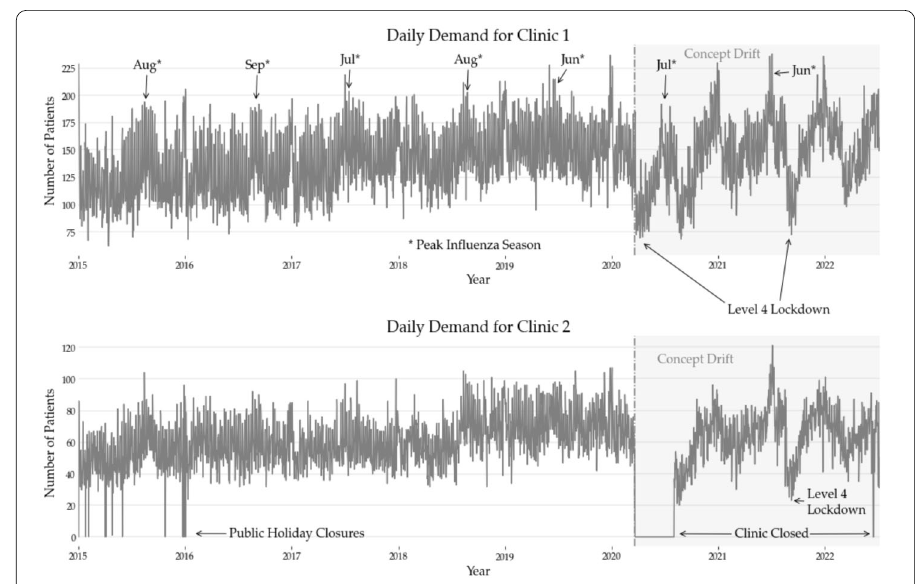
Figure 2 Daily patient demand at both UCC clinics ranging from 2015–2021